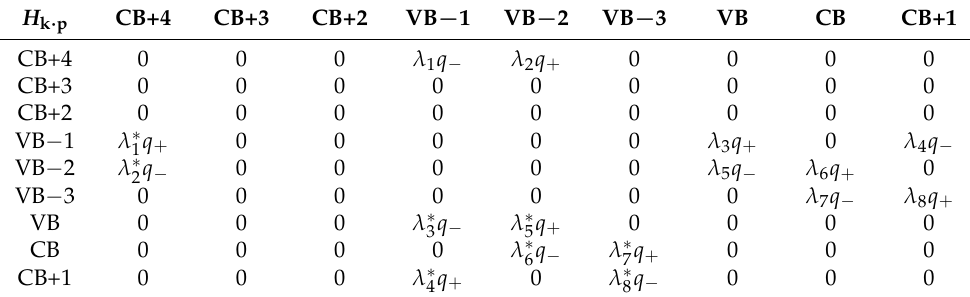
Table A3. k · p matrix elements at Γ point of the